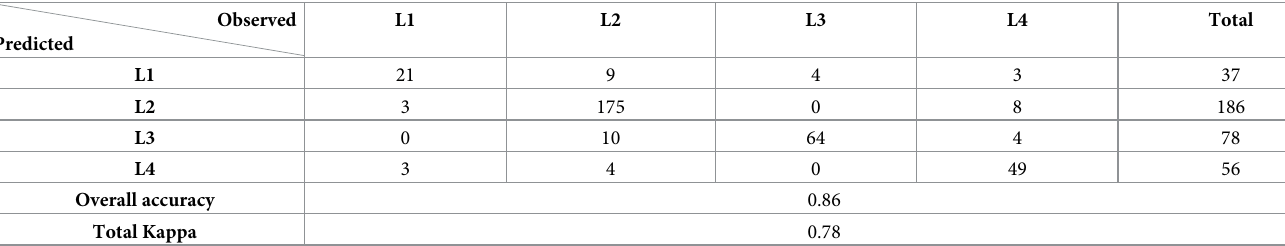
Table 7. Accuracy table of feature information extraction based on RF classifier. Observed